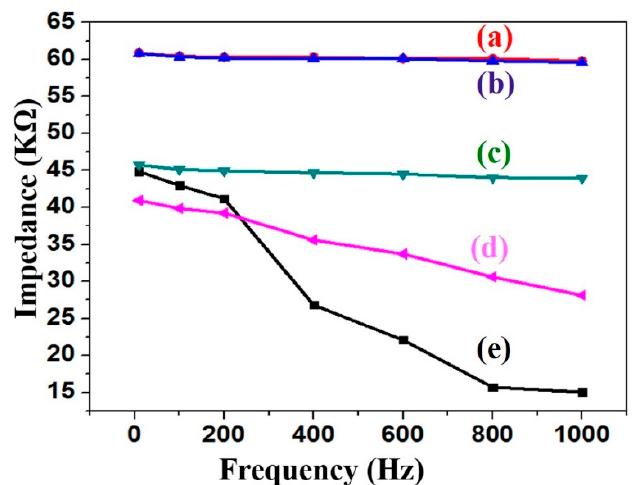
Figure 6. Skin impedance responses of flexible dry ECG electrodes and commercial electrode at frequency range from 10 Hz to 1 KHz. Skin–electrode contact impedance of ( a ) CG, ( b ) CG/f@MWCNTs-15%, ( c ) CG/f@MWCNTs-25%, ( d ) CG/f@MWCNTs-35%, and ( e ) Ag/AgCl.